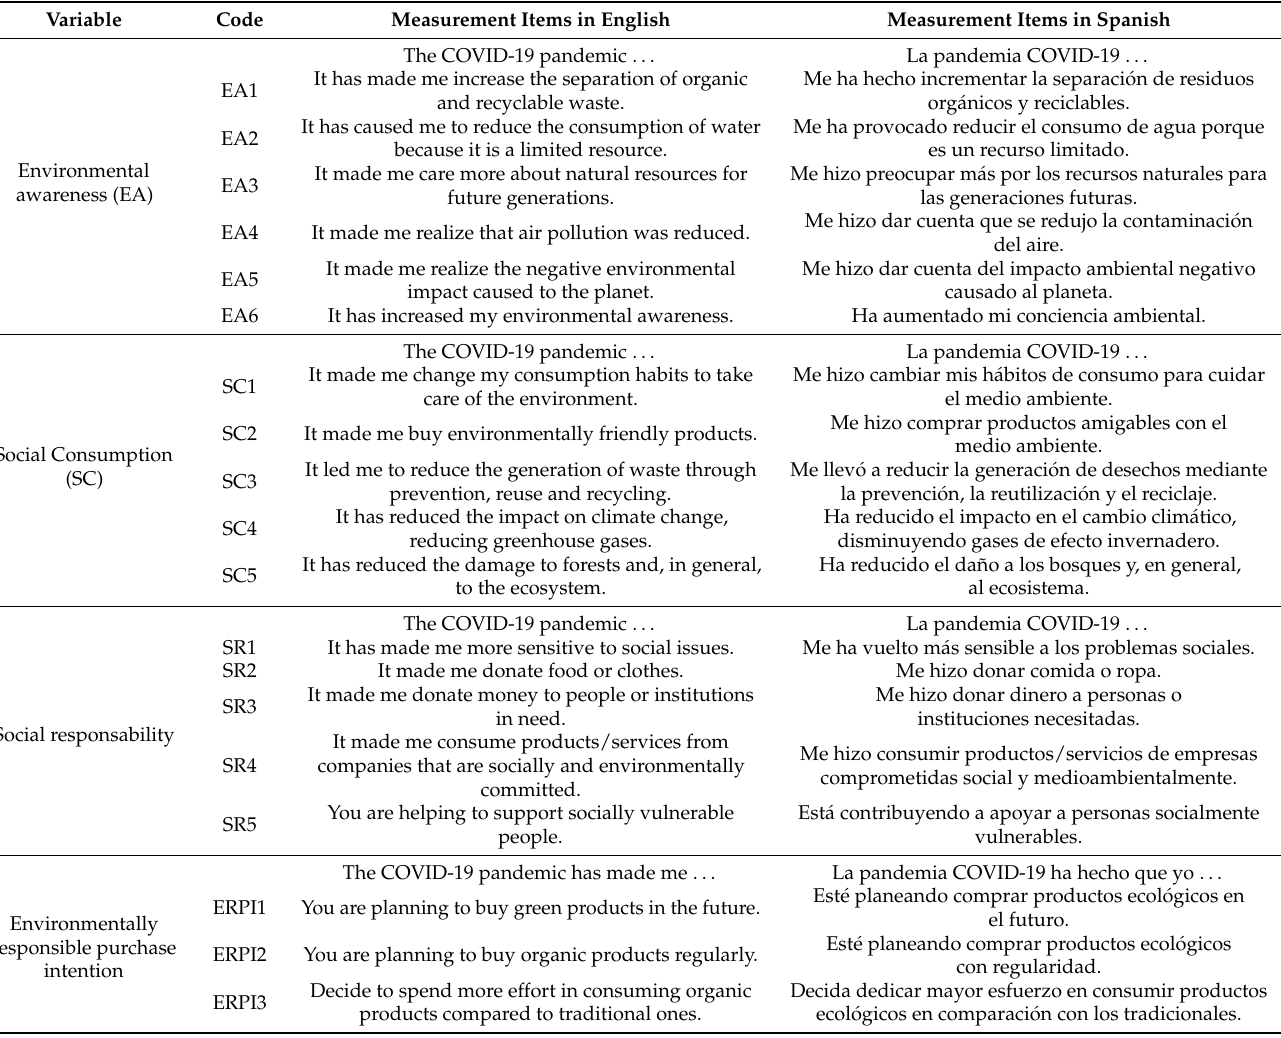
Table 2. Construct.